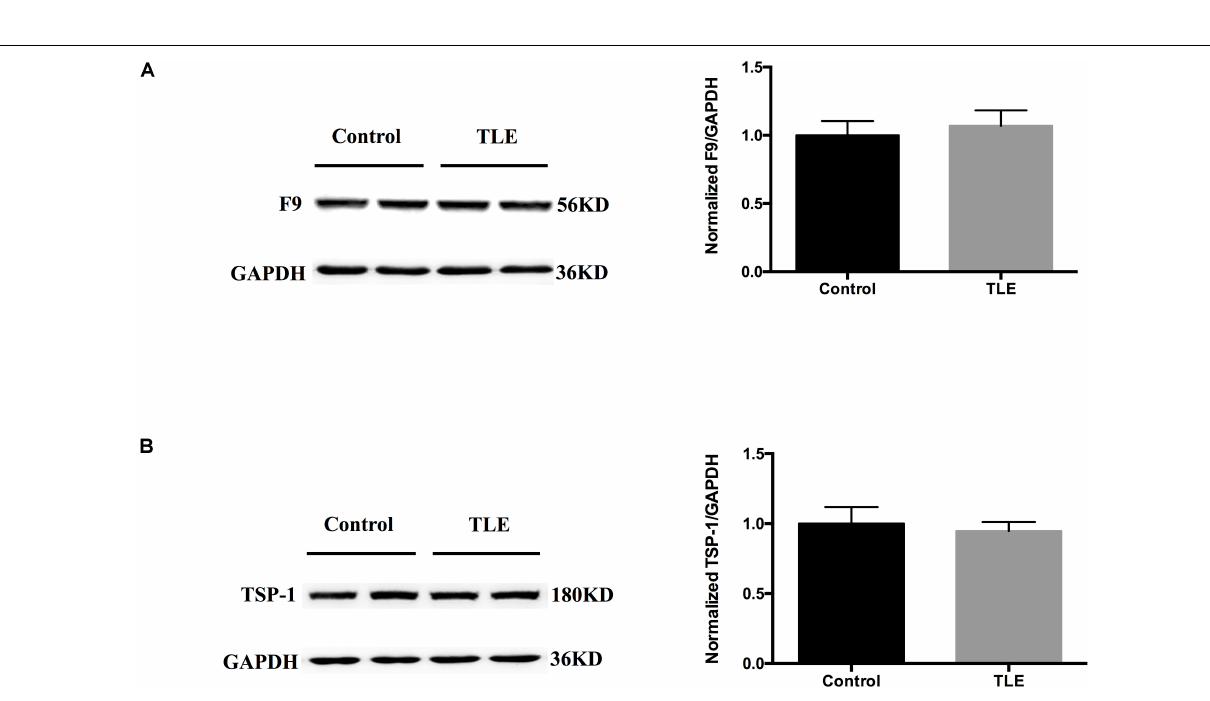
FIGURE 6 | Expression of F9 and TSP-1 in brain tissue exosomes from patients with TLE. (A,B) Western blots demonstrated that the levels of exosomal TSP-1 protein and exosomal F9 protein were not significantly different in the temporal lobe tissues of TLE patients ( n = 4) compared with that of control patients ( n = 4). Mean ± SEM Student’s t -test was